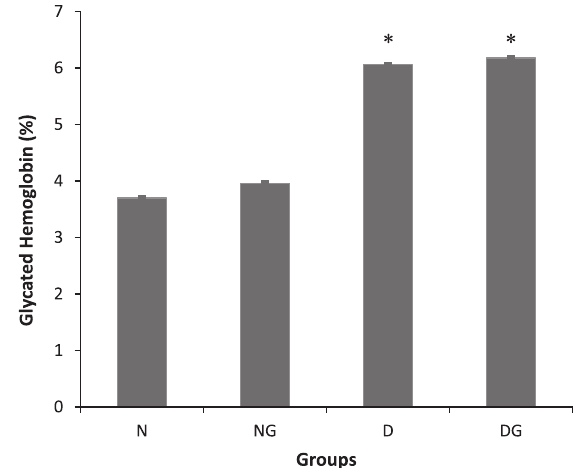
Figure 1 - Glycated hemoglobin (%) in normoglycemics (group N), normoglycemics supplemented with L-glutamine (group NG), diabetics (group D), and diabetics supplemented with L-glutamine (group DG). n = 5 rats per group. * P < 0.05, compared with groups N and NG. HuC /d-ir n eurons